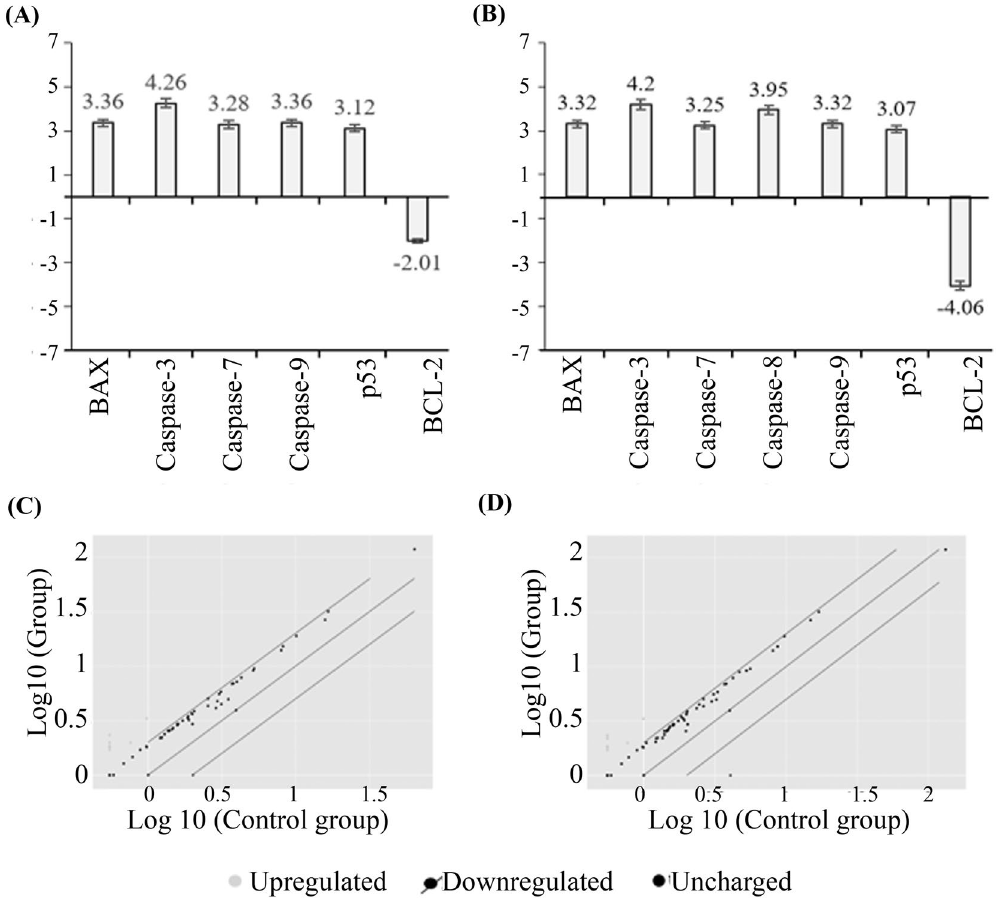
Figure 11. RT 2 Profiler PCR Array (PAHS-012ZA) for MDA-MB-231 cell lines. ( A ) The fold change values for cancer cells treated with the AtMP1, ( B ) fold change values for cancer cells treated with the AtMP2. ( C ) The Scatter Plot compares every gene’s normalized expression on the PCR Array for cancer cells treated with the AtMP1, ( D ) the Scatter Plot compares the normalized expression of every gene on the PCR Array for cancer cells treated with the AtMP2. The results analysis by using Gene Globe Data Analysis. Genes showed less than 1.5-fold change were neglected. The full list of genes was mentioned in supplementary figures file (Supplementary Tables S1,